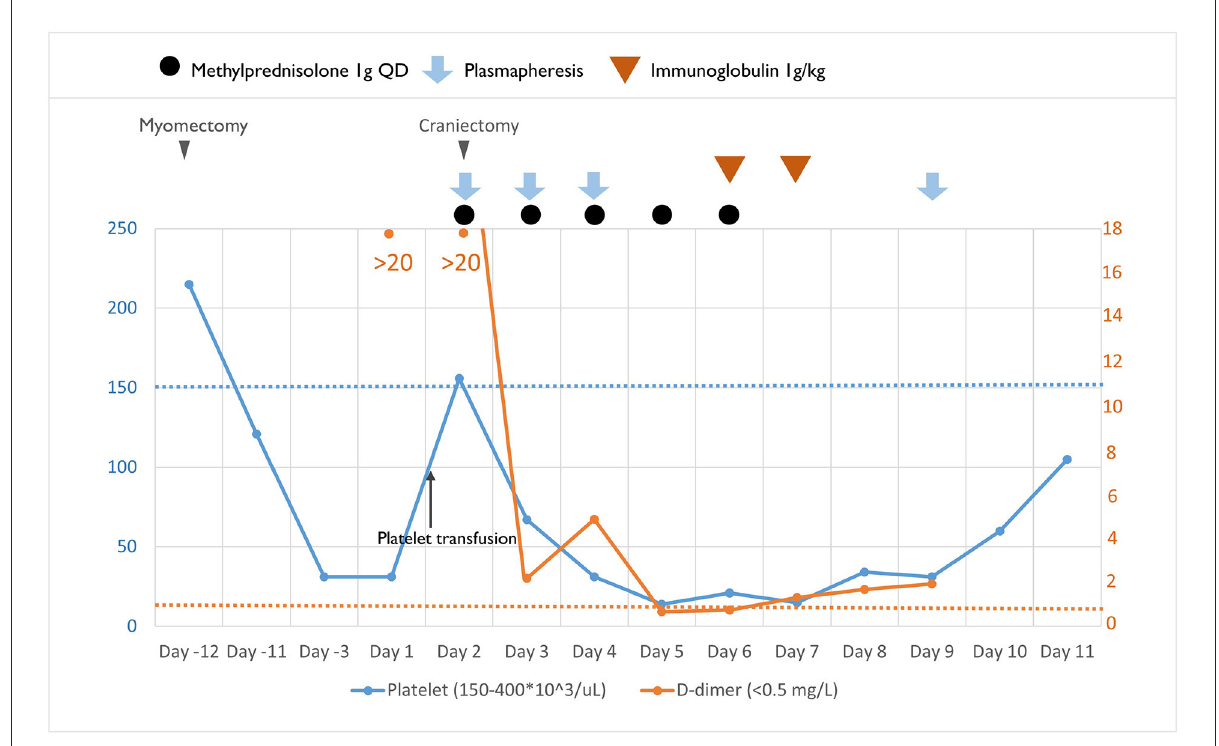
FIGURE3 Clinical course, the laboratory studies and therapeutic agents